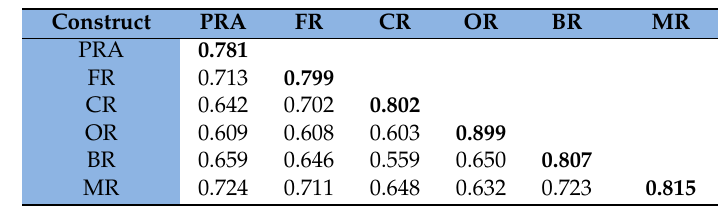
Table 5. Reliability and Inter-Construct Correlations for the Reflective Scales.